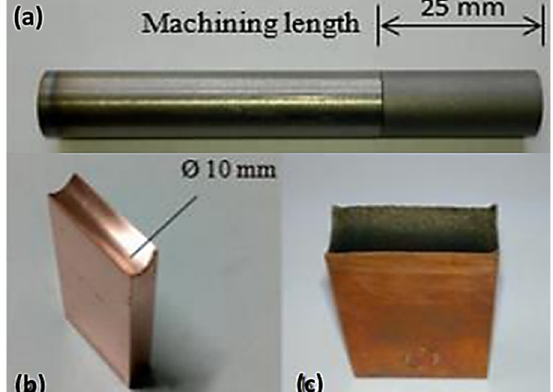
Figure 4. TET turned titanium bar and rectangular copper tool electrode: ( a ) turned titanium bar; ( b ) copper tool electrode before turning; ( c ) copper tool electrode after turning (Reprinted/Adapted with permission from [25]. 2018, Elsevier.